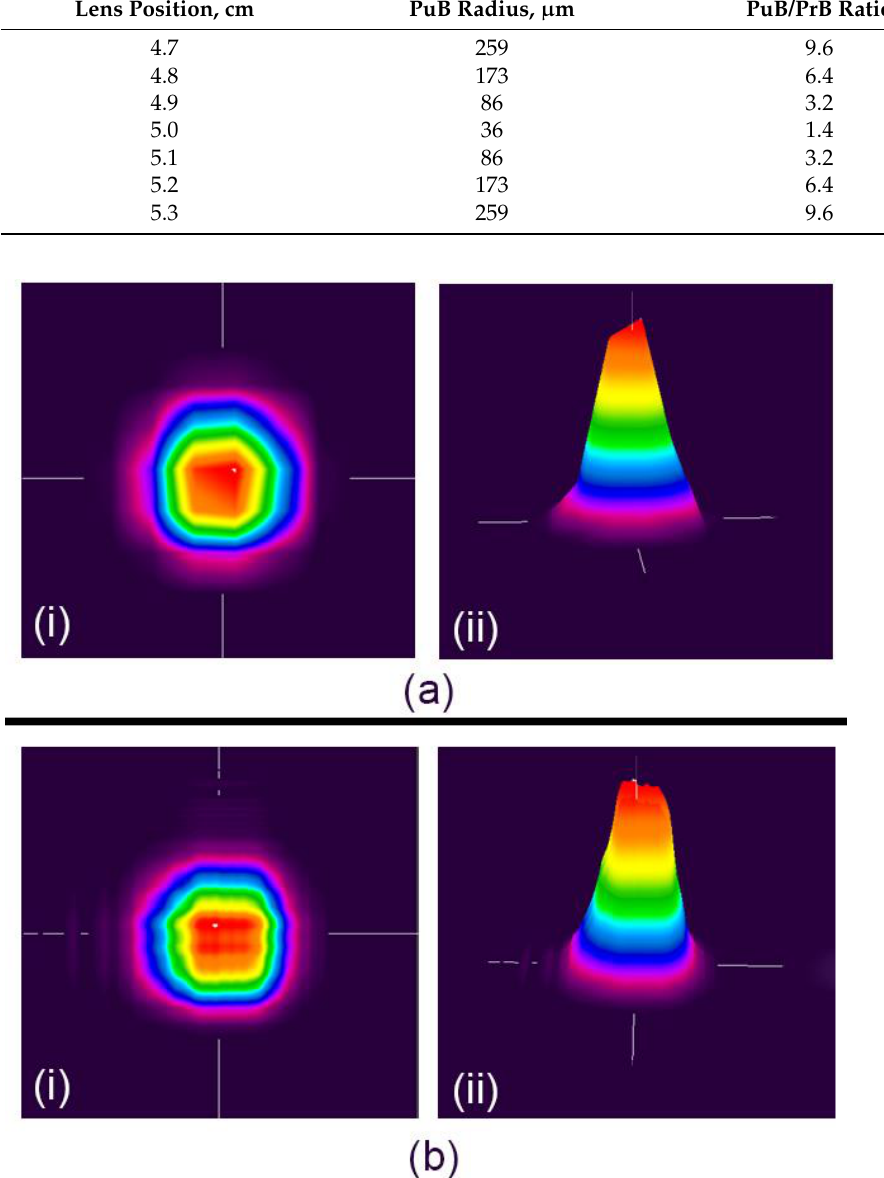
Figure 3. ( i ) 2D profile and ( ii ) 3D profile of the excitation laser when the lens is placed at ( a ) f = 5.3 cm and ( b ) f = 4.7 cm.